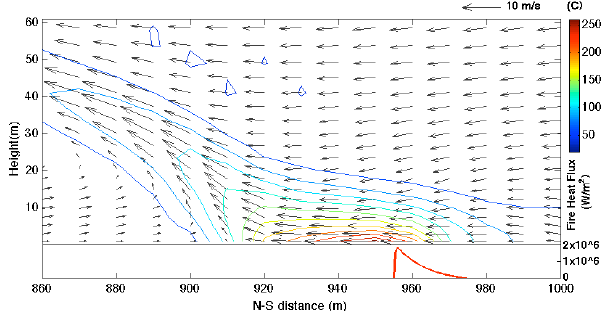
Fig. 13. Vertical y – z cross section at x = 465m, 225s into simula- tion. Vectors denote wind components in y – z plane where magni- tude is scaled as indicated in the top right corner of plot. Contour lines represent air temperature ( ◦ C), and the magnitude of each con- tour line is indicated by the color bar on the right side of the plot. The red thick line shows the ERR (Wm − 2 ) computed on the fire